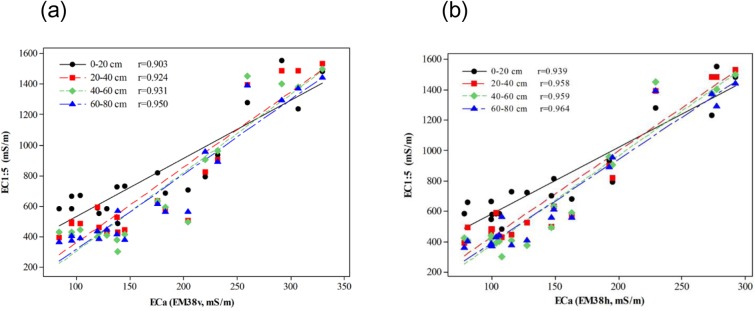
Pearson correlation coefficients between soil EC1:5 (mS/m) of the calibration points at various depths and ECa (mS/m) measurements with regard to EM38v (a) and EM38h (b).